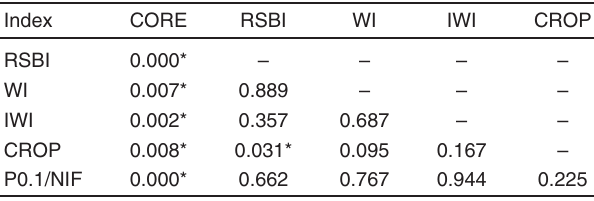
Table 5 Comparison of the areas under the receiver operator characteristic curves for the studied weaning indices (